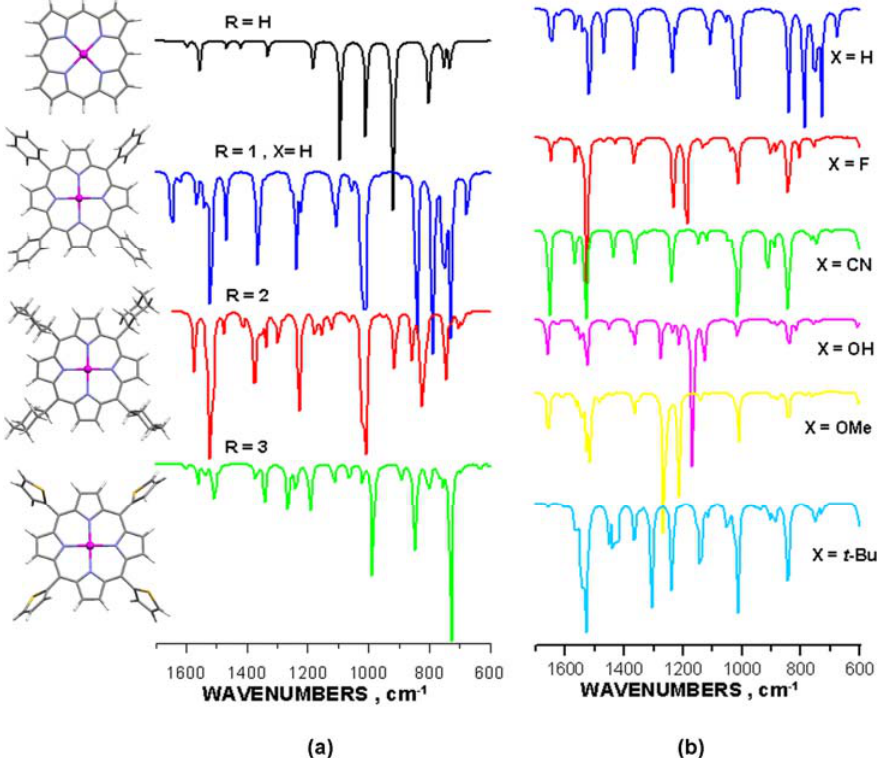
-R oscillations for diverse meso -substituted μ -C and C -C (see also Table SI-1, Supplementary α μ β β